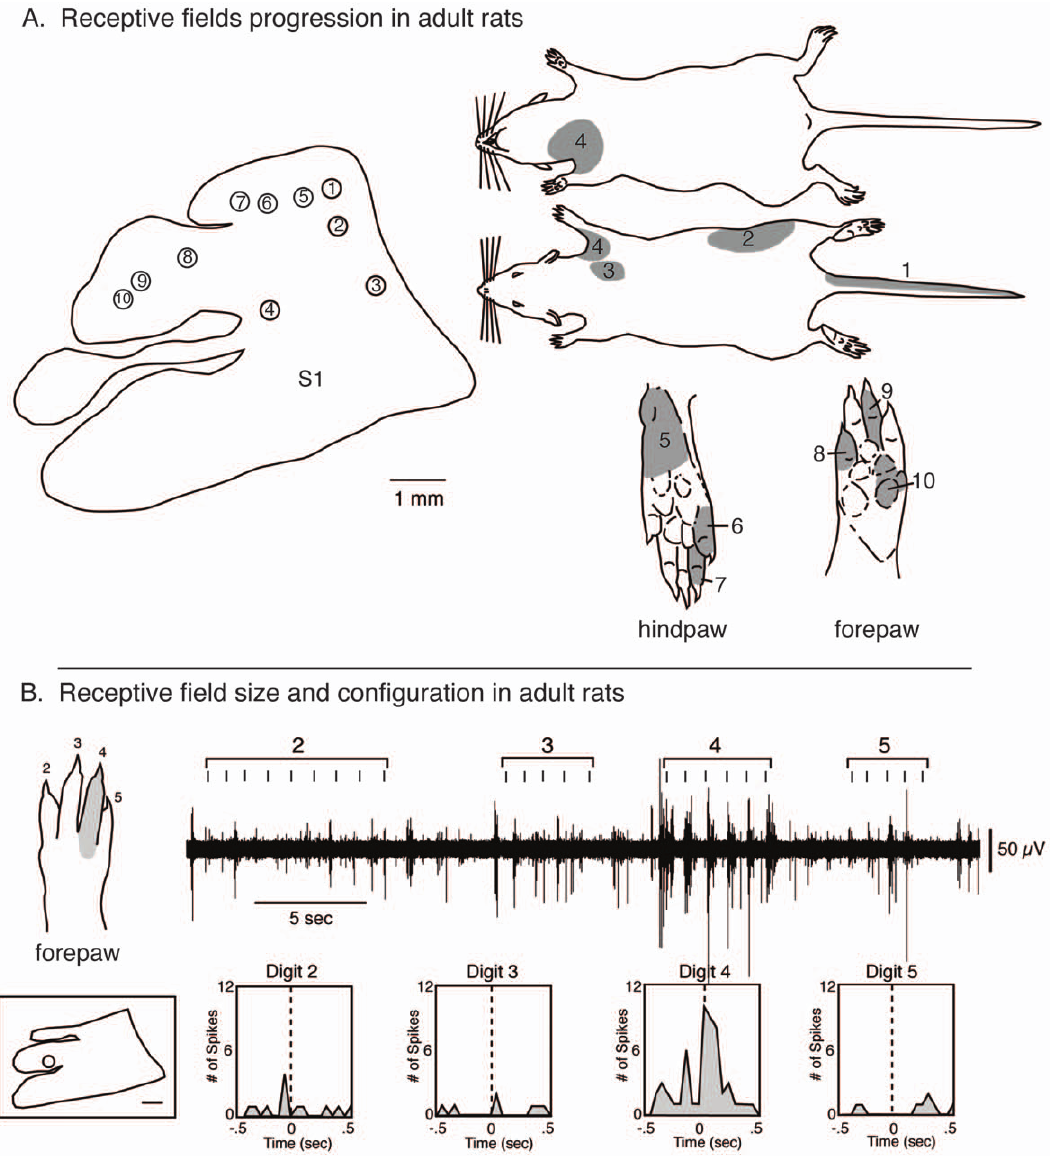
Figure 11. Receptive field progressions in an adult rat. Progressions of recording sites in S1 in an adult rat (left in A) and corresponding receptive fields for neurons at those sites (right in A). Numbered sites in the cortex correspond to numbered receptive fields on the body. Receptive fields are shaded grey. In adults, the topographic organization is precise and consistent across animals. As recording sites progress from medial to lateral in the caudal portion of S1 (sites 1–4) corresponding receptive fields move from the tail, lower trunk to upper trunk. The hindpaw (5–7) and forepaw (8–10) have corresponding progression from toes 5–1 and digits 5–1, respectively. Compare this figure with the full map of the body illustrated in Figure 1. B) Representative trace of cortical activity in response to stimulation of digits of the contralateral digit 4 (top left) in an adult rat. In the top left drawing of the forepaw, each digit is labeled with its corresponding number, and the receptive field on dorsal digit 4 is shaded in grey. In the bottom left is a schematic of S1 with the recording site marked with an open circle (scale=1 mm). A trace of multi-unit activity is located to the right of the forepaw schematic. Tic marks represent the temporal pattern of stimulation. Peri-event histograms, labeled with their corresponding digit, show the increase in the amount of cortical activity in the 1 second surrounding digit stimulation.